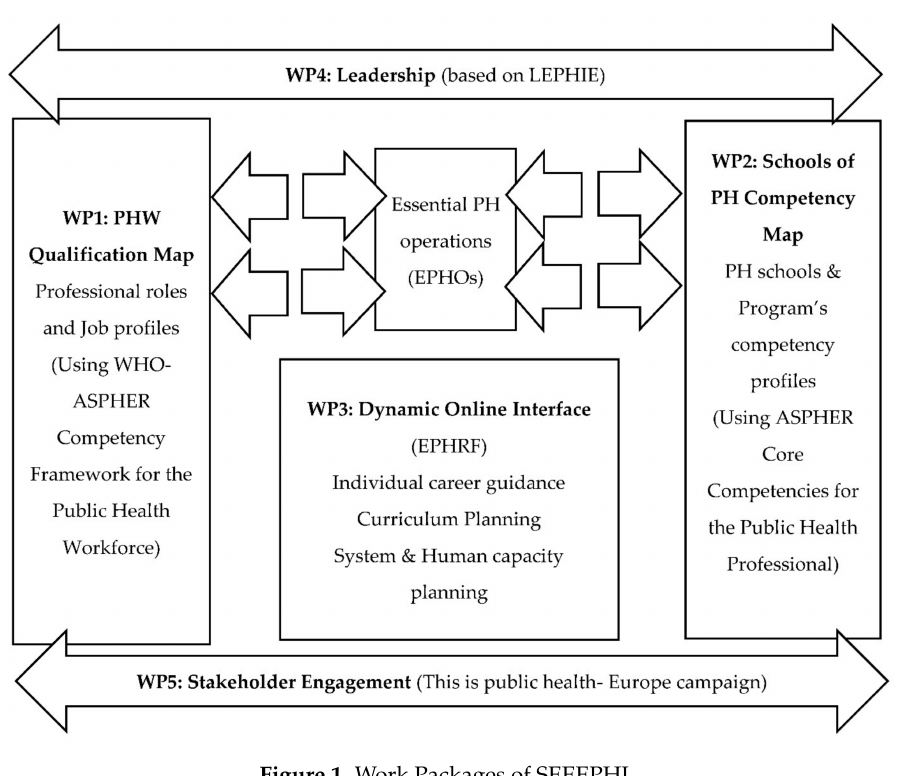
Figure 1. Work Packages of